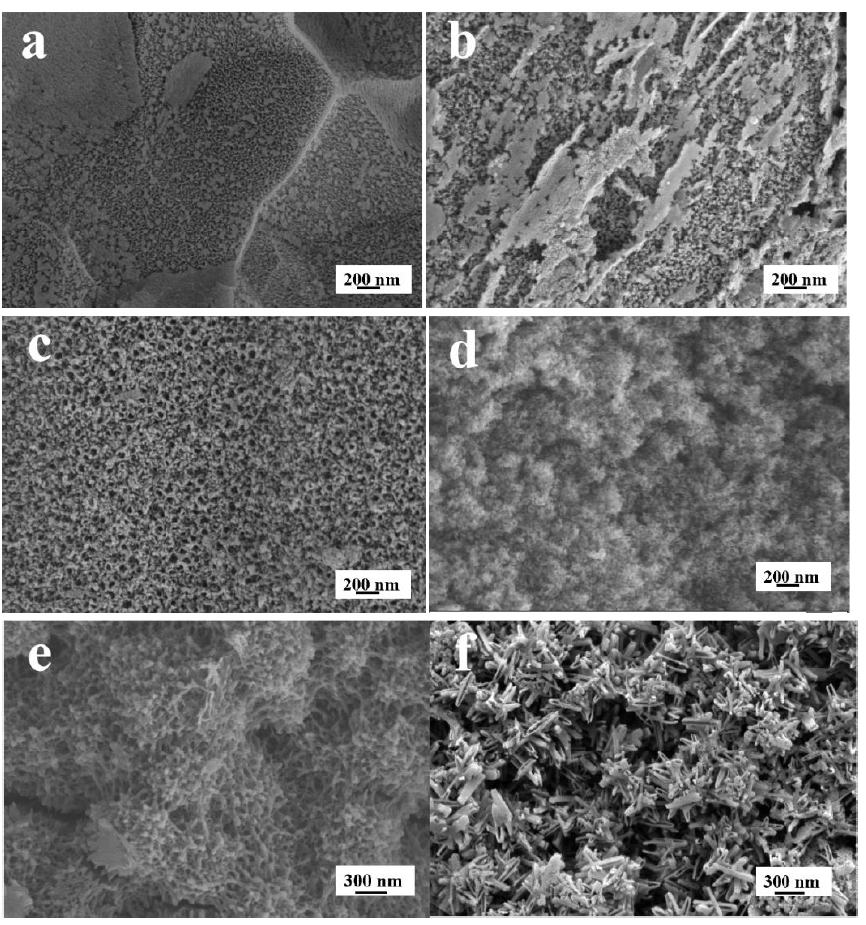
Figure 4. SEM images of in-situ titanium oxide wires at different voltages ( a ) 10 V; ( b ) 15V; ( c ) 20 V; ( d ) 25 V; ( e ) 30 V; ( f ) 25 V.